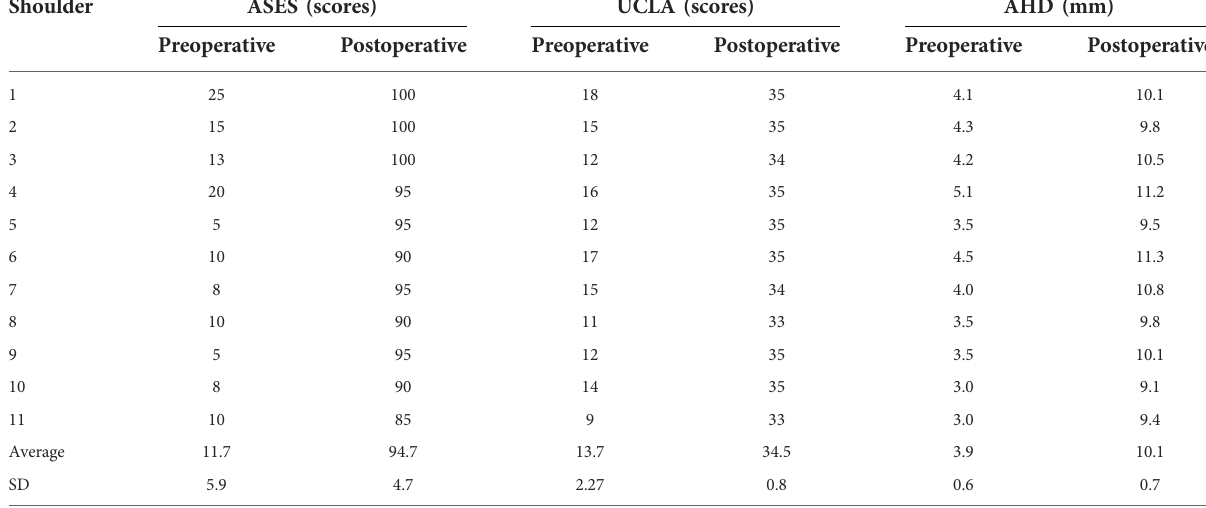
TABLE 2 Summary of patients ’ shoulder functional